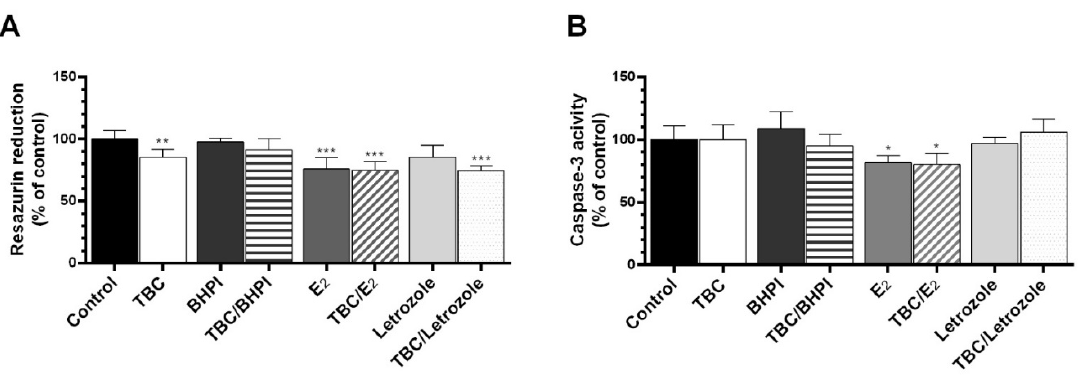
Figure 2. Effect of 10 µ M of TBC and TBC in the cotreatment (BHPI—10 µ M, E 2 —100 nM, letrozole— 1 µ M) on the level of resazurin reduction ( A ) and caspase‑3 activity ( B ) in the GC‑1 spg cell line after 48 h exposure. Data are expressed as means ± SD of three independent experiments, each conducted in six replicates per treatment group. * p < 0.05, ** p < 0.01, *** p < 0.001 vs. the vehicle control